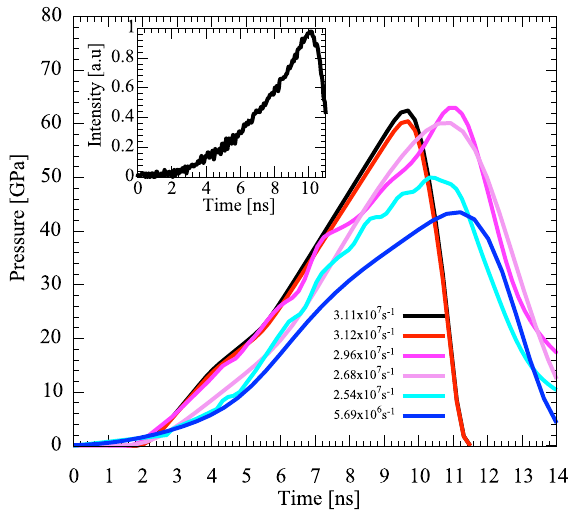
Figure 3. Pressure loading profiles as simulated by the code MULTI [15] (see in the text) and used as boundary conditions in our simulations. Inset: typical example of measured laser intensity